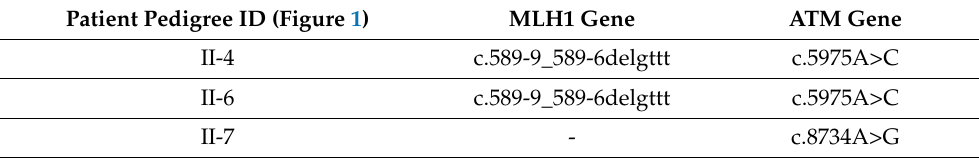
Table 1. Genotypes of our index case’s